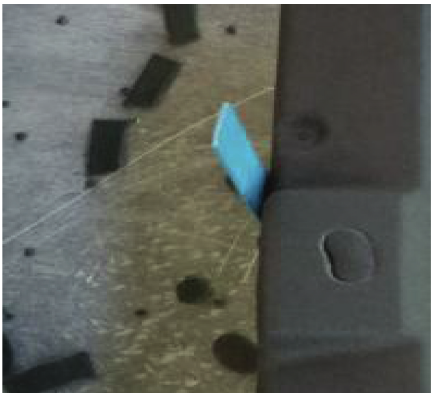
Figure 13: Removing